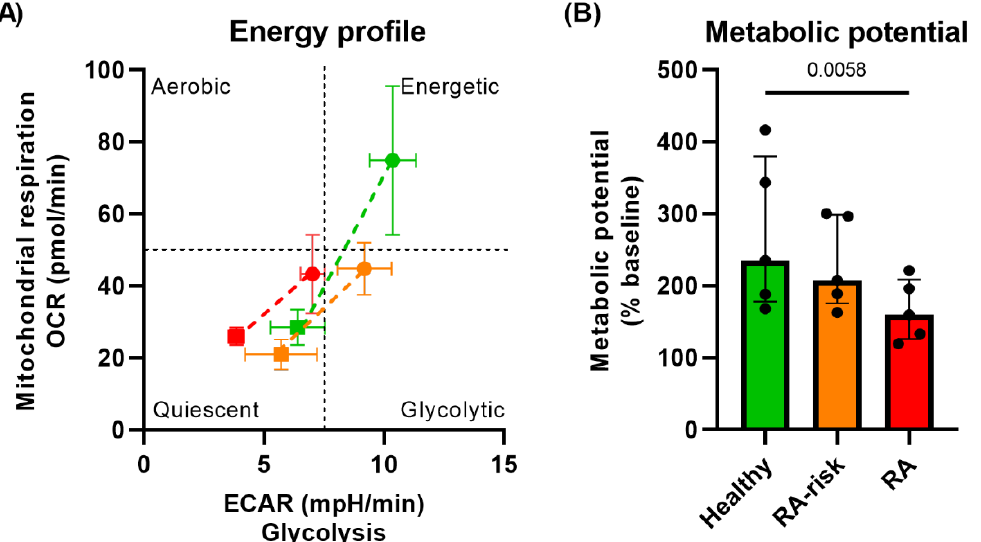
Figure 2. Lower metabolic potential in RA LNSCs compared with healthy LNSCs. ( A ) Energy profile of cultured LNSCs at basal mitochondrial respiration (squares) and maximum mitochondrial respiration (circles) based on the OCR and ECAR. ( B ) Metabolic potential of cultured LNSCs. All donors passage 4, unstimulated conditions. N = 5 per group and five technical replicates per condition, mean value of five replicates per donor is displayed. Data are normalized according to cell input and presented as median + interquartile range. Statistical differences were determined using two-way ANOVA + Dunnett’s T3 multiple comparisons test.